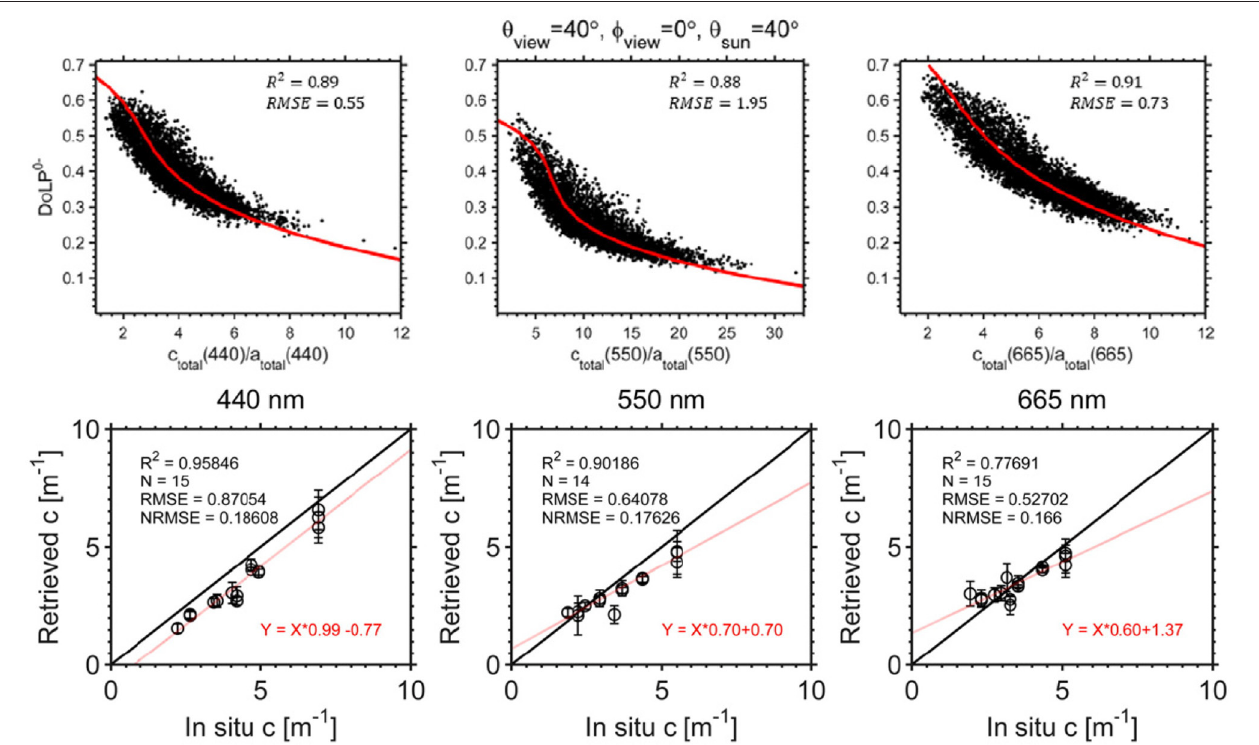
FIGURE 6 | The upper row shows the simulated DoLP just beneath the ocean surface vs. the ratio of the attenuation to absorption coefficients for three wavelengths in the visible wavelengths at one specific geometry and for a wide range of coastal ocean IOPs. The lower row is the validation based on in-water polarimeter observations and in-water beam attenuation coefficient measurements from WETLabs ac-s. Reuse with permission from Ibrahim et al. (2016).